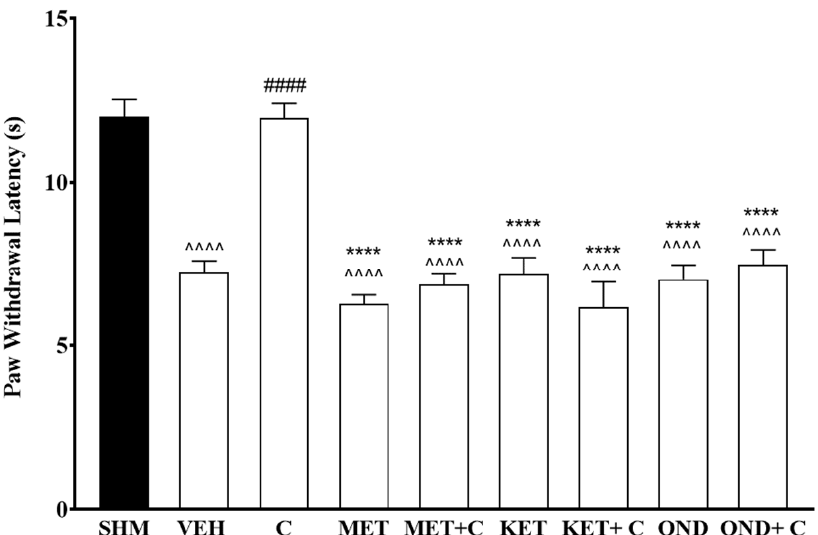
Figure 3. Effect of methiothepin (5-HT1/6/7 receptor antagonist), ketanserin (5-HT2A receptor an- tagonist), and ondansetron (5-HT3 receptor antagonist) pre-treatment on cardamonin against ther- mal hyperalgesia of CCI-induced neuropathic pain mice were evaluated using Hargreaves’ Plan- tar test. Data were presented as mean ± SEM ( n = 6). The caret, hash, and asterisks denote the sig- nificance levels (one-way ANOVA, followed by Tukey’s post hoc test, ^^^^ p < 0.0001 as compared to sham, #### p < 0.0001 as compared to vehicle and **** p < 0.0001 as compared to cardamonin-treated group. SHM (Sham); VEH (Vehicle, 10 mL/kg i.p.); C (Cardamonin, 10 mg/kg i.p.); MET (Methio- thepin, 0.1 mg/kg, i.p.); KET (Ketanserin, 0.3 mg/kg, i.p.); OND (Ondansetron, 0.5 mg/kg, i.p.).